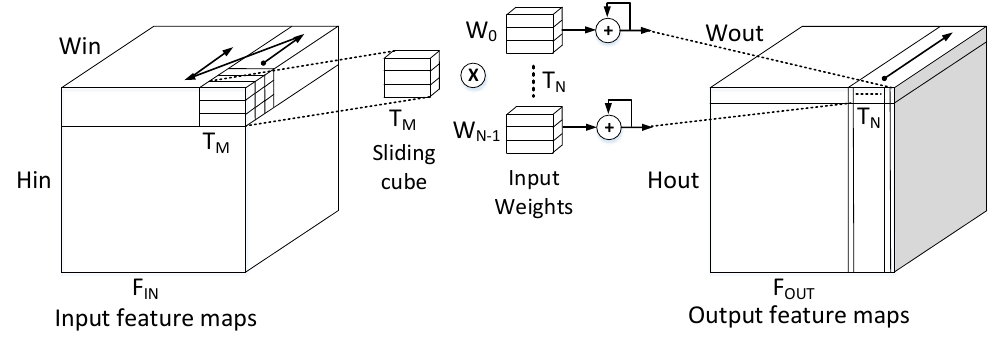
Figure 4. Streaming convolution layer data